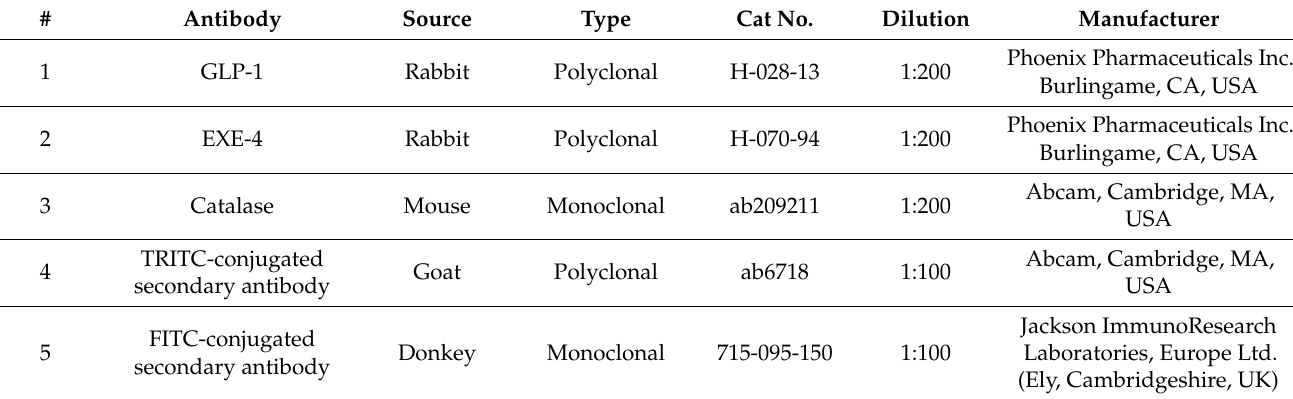
Table 1. List of primary and secondary antibodies used for